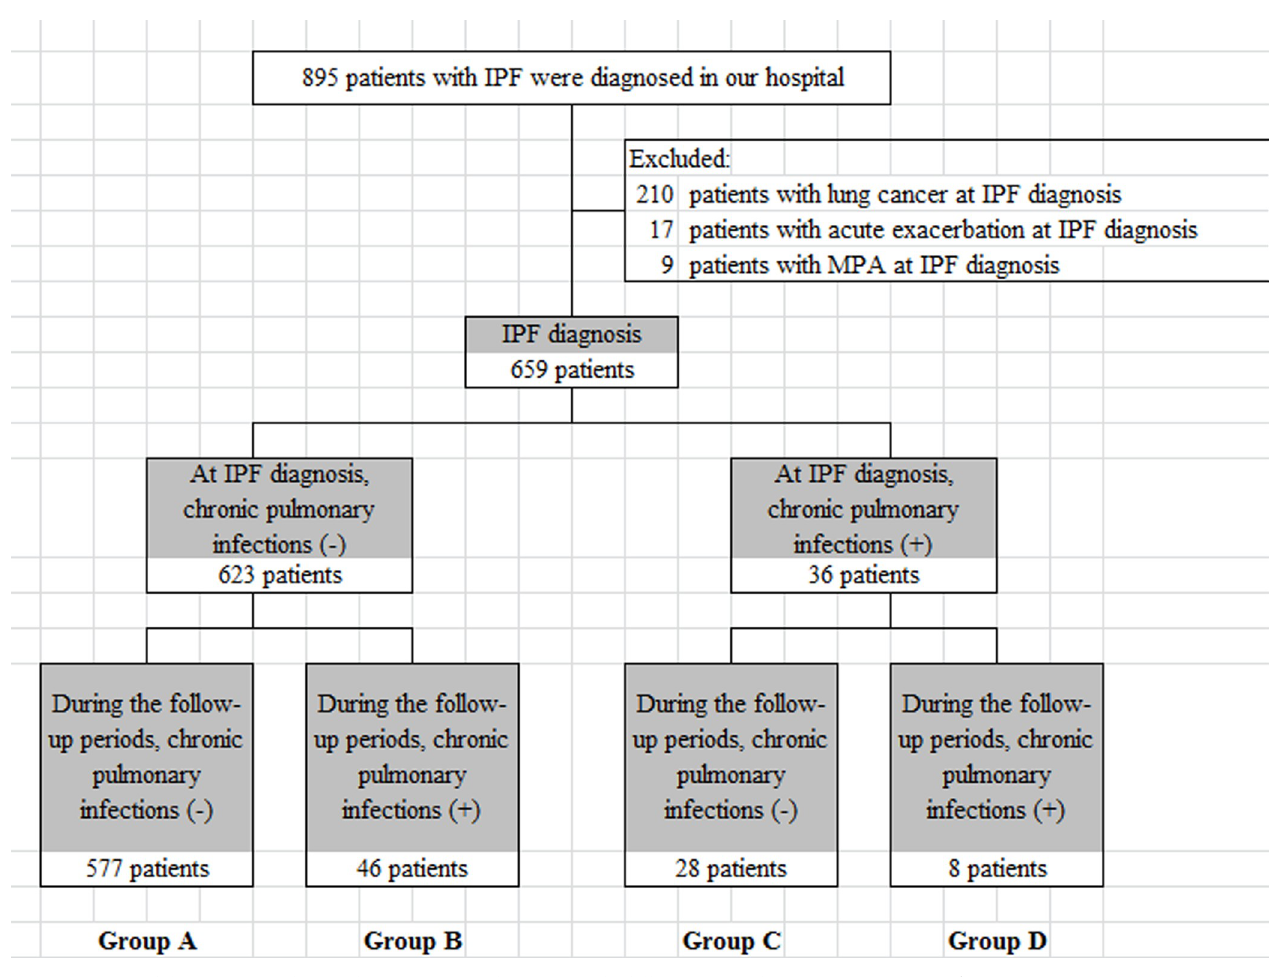
Fig 1. Diagram of the patients with or without CPI at IPF diagnosis or the follow-up period. MPA = microscopic